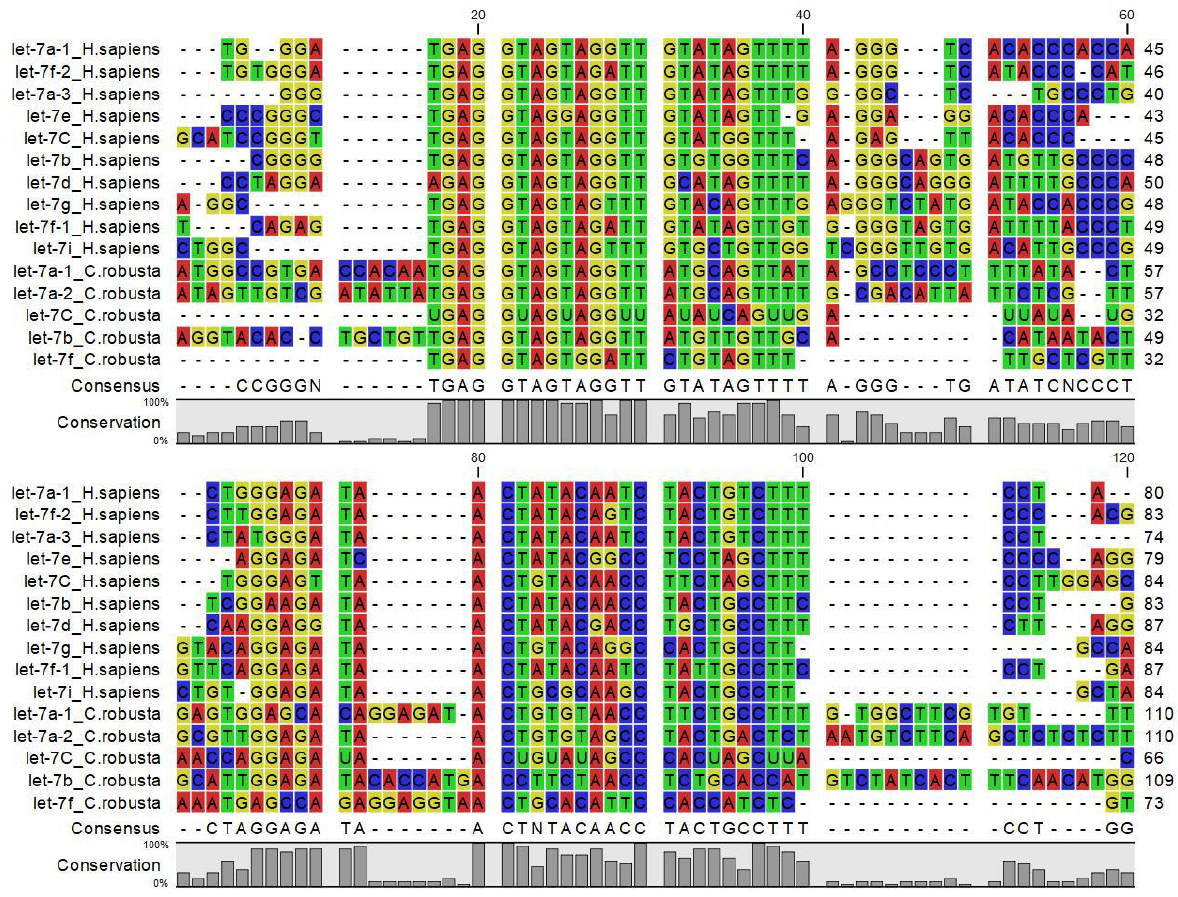
Figure 3. Multiple amino acid sequence alignment of Let7 miRNA family members from invertebrate, vertebrates and C. robusta .